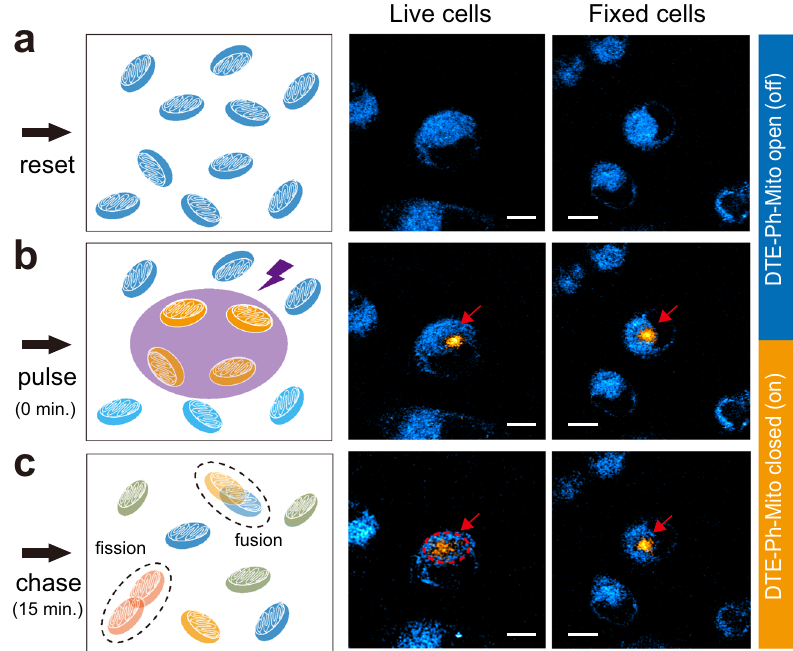
Fig. 4 Intracellular pulse-chase experiments of mitochondria diffusion with SRS. a DTE-Ph-Mito labeled cells were prepared in the initial “ off ” state. b A small con fi ned portion of mitochondria were selectively turned on (pulsed) by UV irradiation, and imaged with dual-color SRS to map out both the “ off ” (cyan) and “ on ” (yellow) state molecules. c After 15 min, the changes of the “ on ” state mitochondria were imaged (chased). Fixed cells were used as the control group. Scale bar: 10 µ